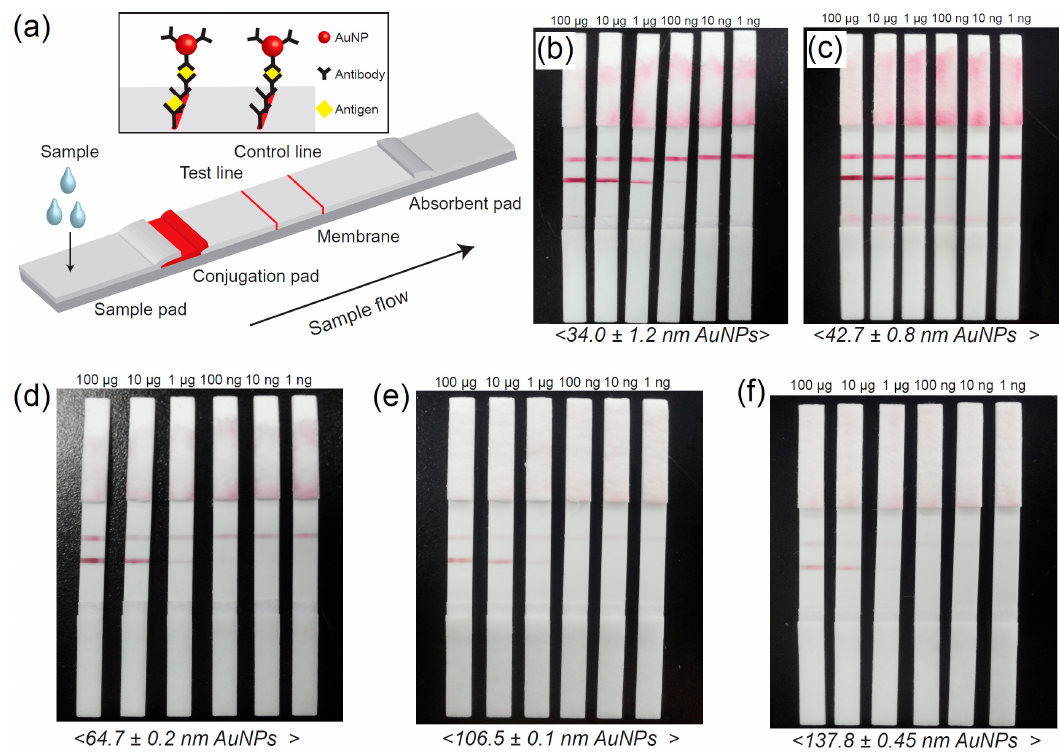
Figure 5. ( a ) Schematic illustration of LFA. Photographs of LFA test results based on different-sized AuNPs of ( b ) 1 step (34.0 ± 1.2 nm); ( c ) 3 steps (42.7 ± 0.8 nm); ( d ) 7 steps (64.7 ± 0.2 nm); ( e ) 10 steps